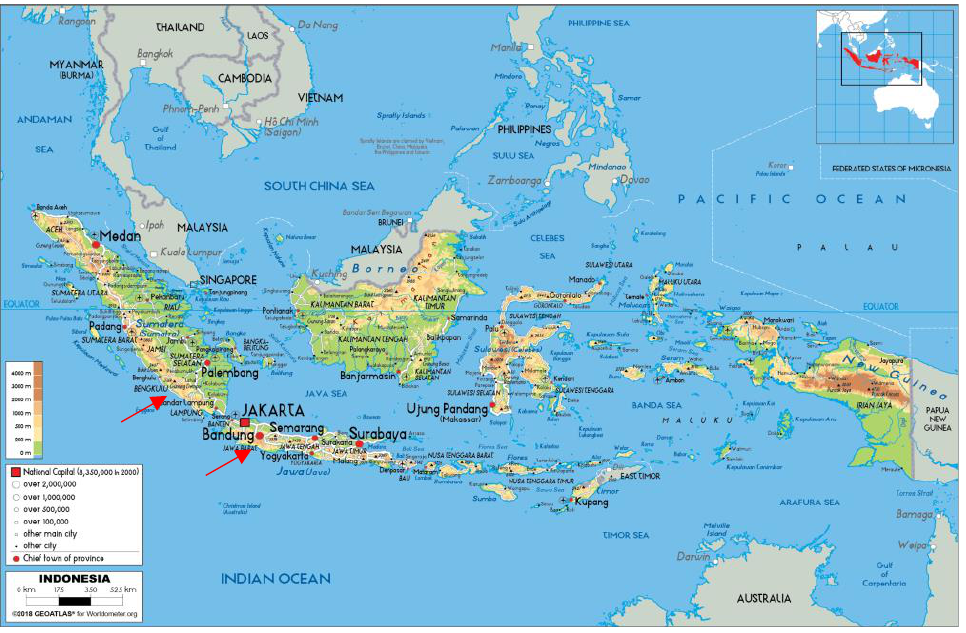
Figure 1. The study areas.